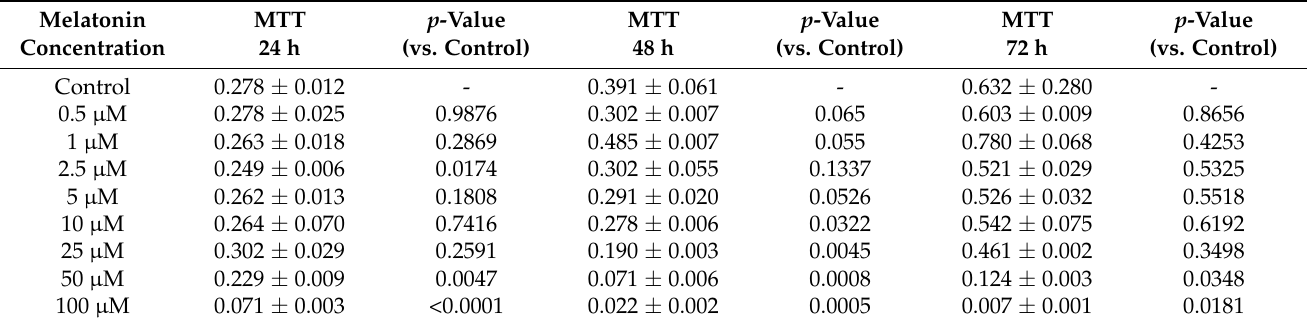
Table 3. MTT assay.